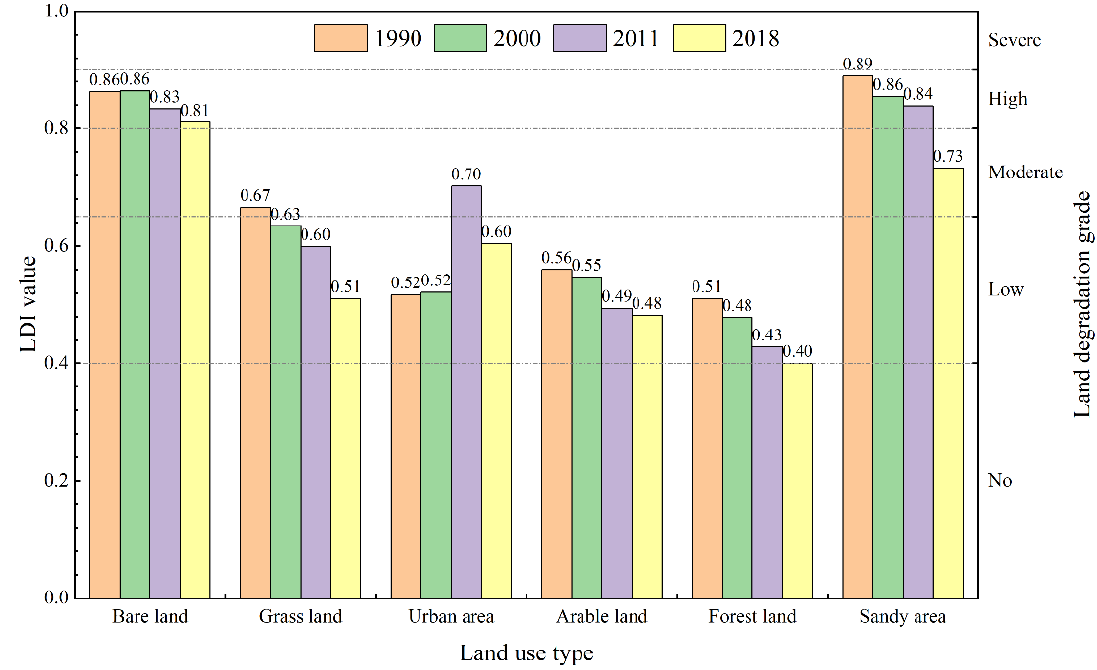
Figure 10. Land degradation index ( LDI ) changes with different land use types during different periods.